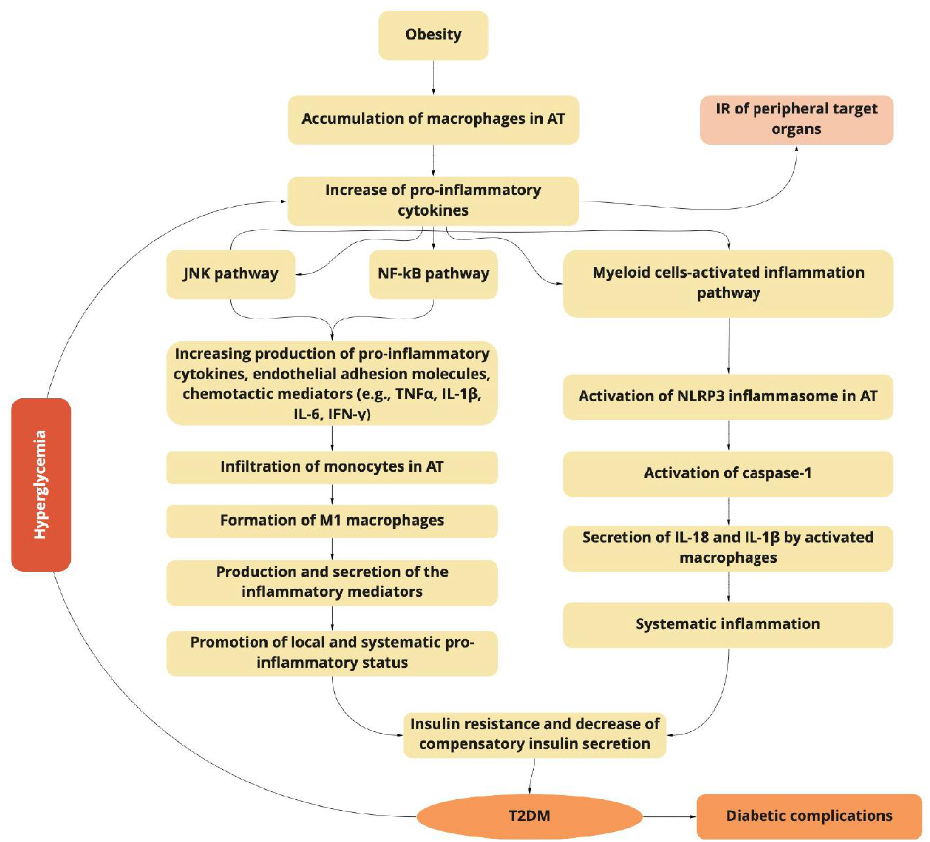
Figure 1. The obesity-related inflammation as a predictor of type 2 diabetes mellitus (T2DM) induction and progression .